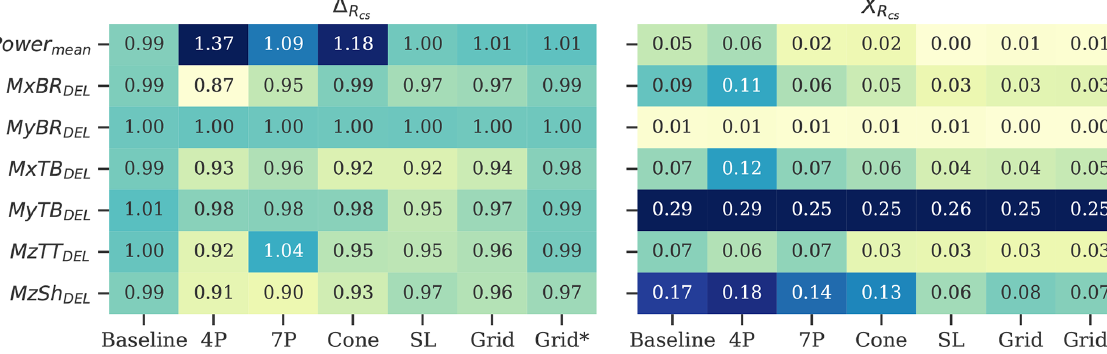
Figure 10. Uncertainty indicators of the load validation analysis based on the constrained field simulations (CSs). Results are tabulated according to the load components and lidar scanning patterns. The color map reflects the amplitude of the error; thus dark blue identifies an overprediction while light green indicates an underprediction. A perfect statistical prediction leads to (cid:49) R = 1 and X R =